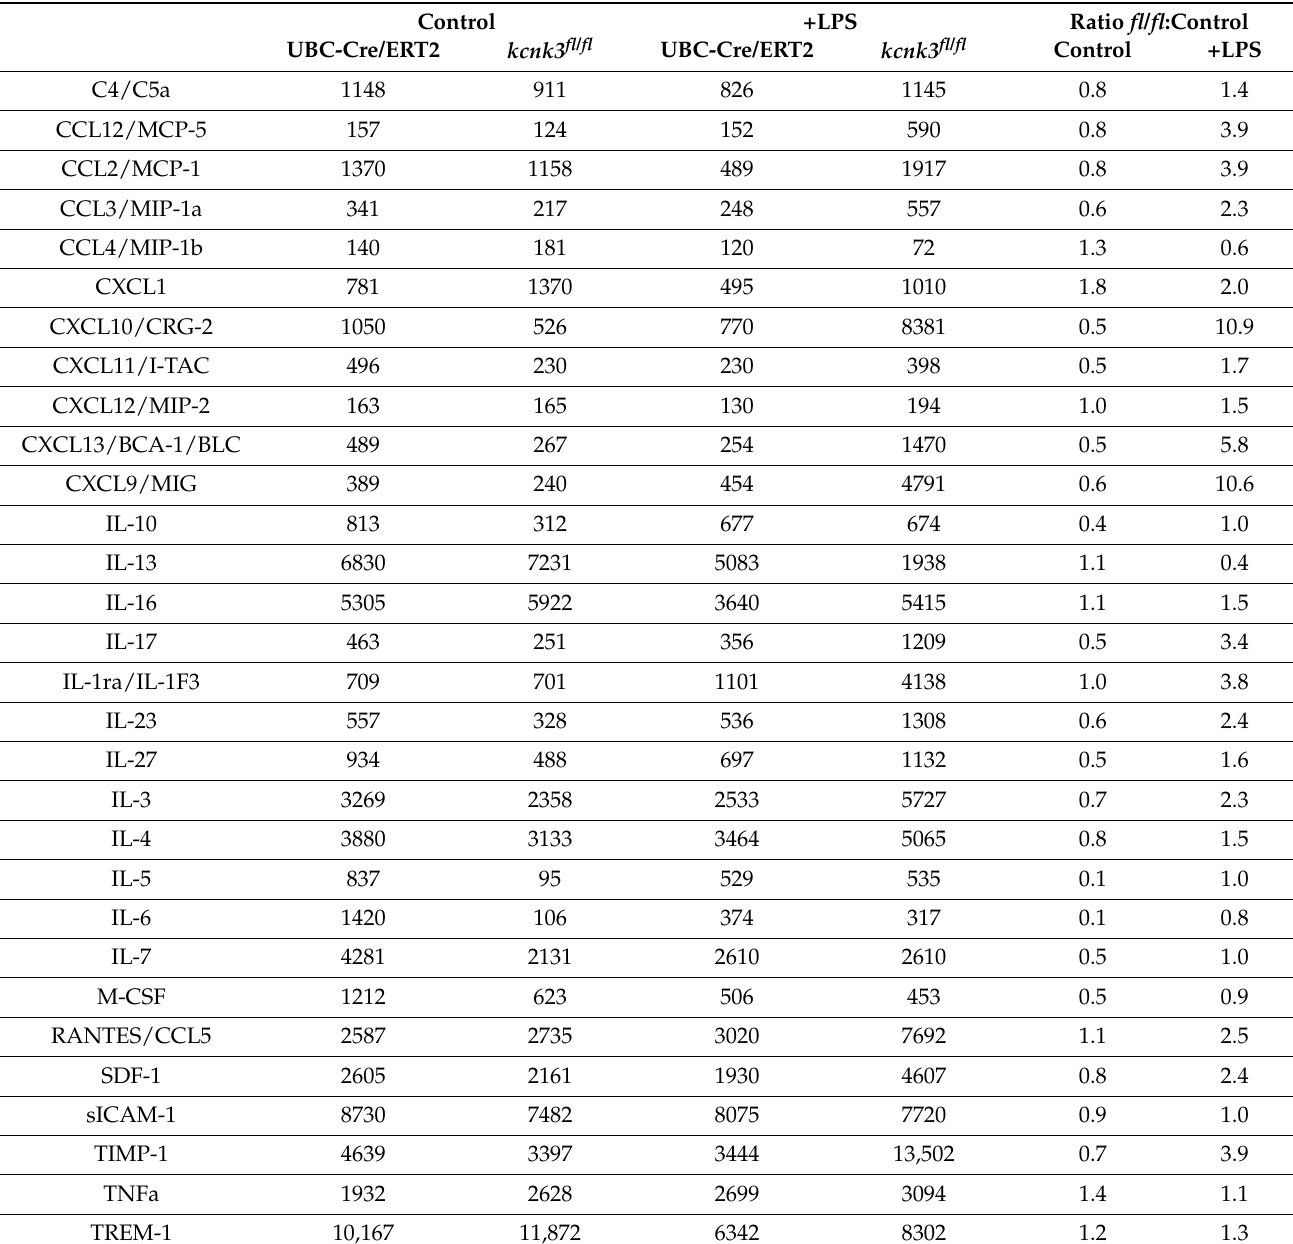
Table 3. Densitometry of cytokine dot blots in whole mouse